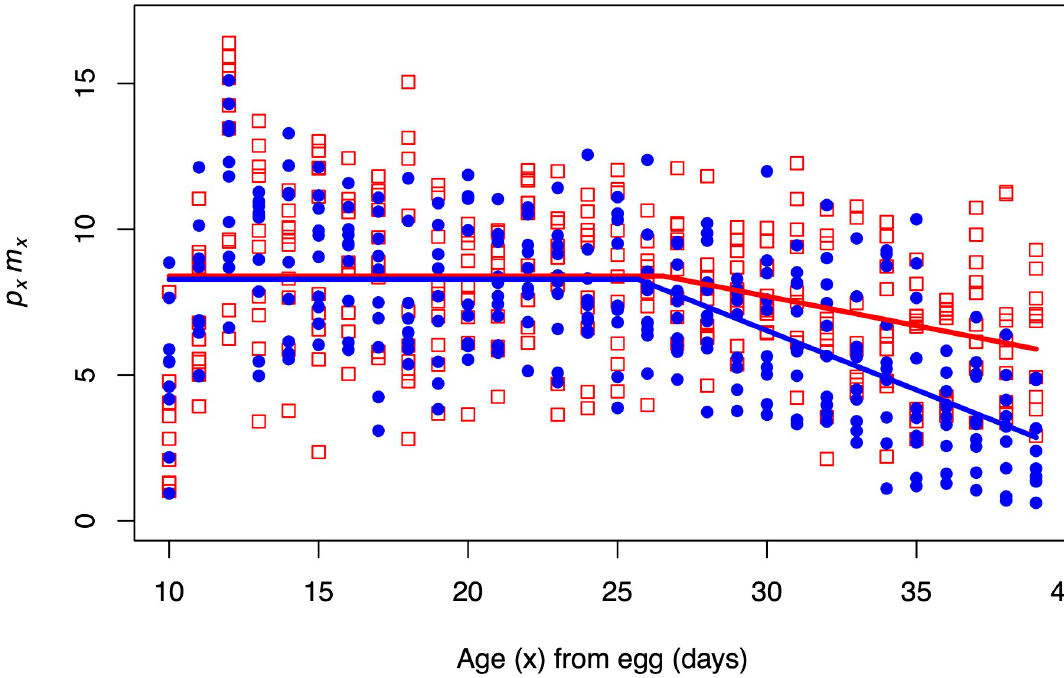
Fig 2. p results for the five ACO populations on the apple and banana diets. Closed blue circles and solid blue lines represent x m x data and regressions from flies fed the banana diet. Open red squares and dotted red lines represent data and regressions from flies fed the apple diet. A significant difference between diets in the intercept from the first stage ( a 0 ) was not observed. There was no significant difference in the breakday ( a 2 ) between diets. Lastly, the second-stage slope ( a 1 ) was significantly more negative for the banana diet.